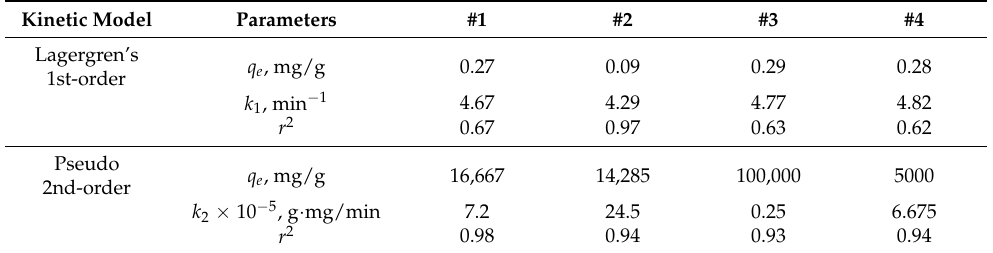
Table 3. Comparing Lagergren’s 1st-order and Pseudo 2nd-order models for Flytekabsorption system. Kinetic Model